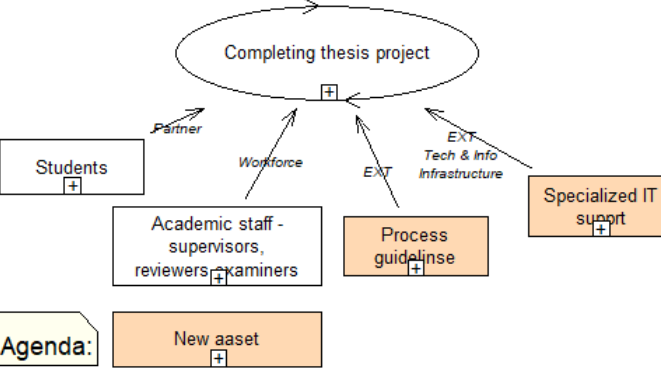
Figure 7. Changes in the thesis